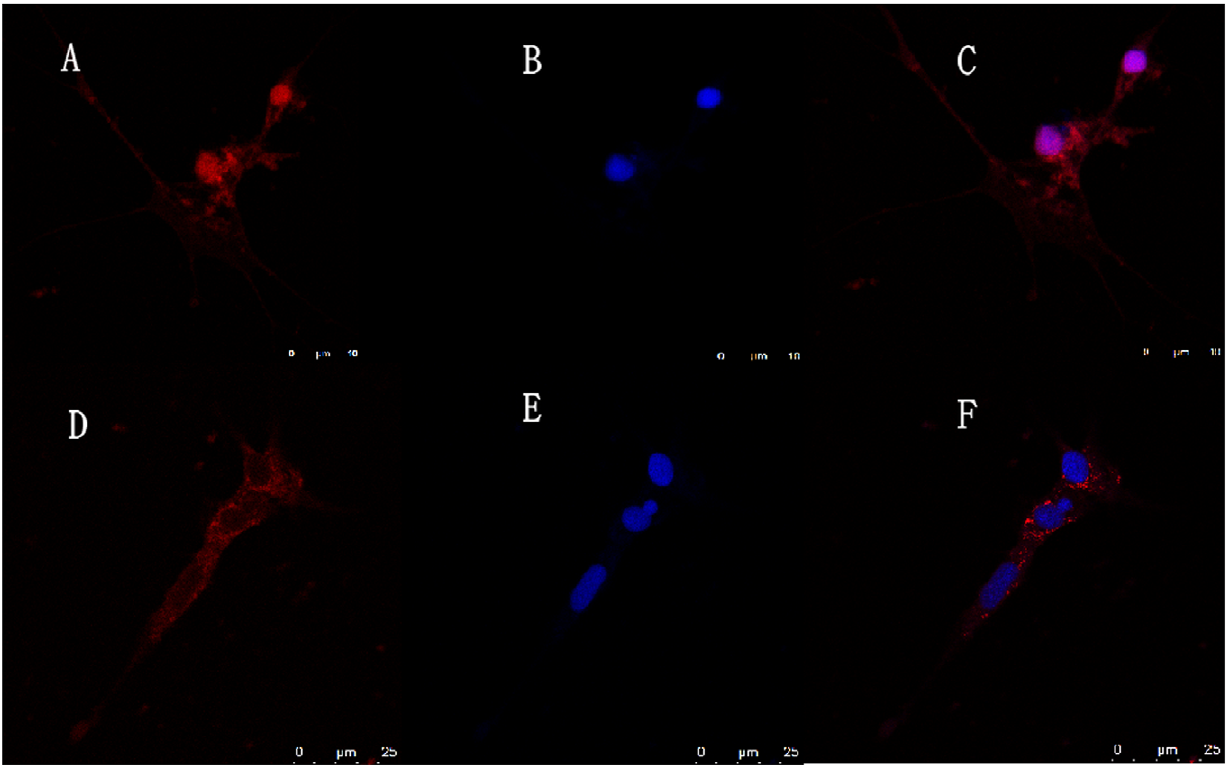
Figure 7. The subcellular localization of Ca-HMGB. A–C: Before RLO challenge. D–F: After RLO challenge. A, D: Immunostaing hemocyte with anti-HMGB; B, E: Imaging of nuclei using the nucleic acid stain DAPI; C, F: